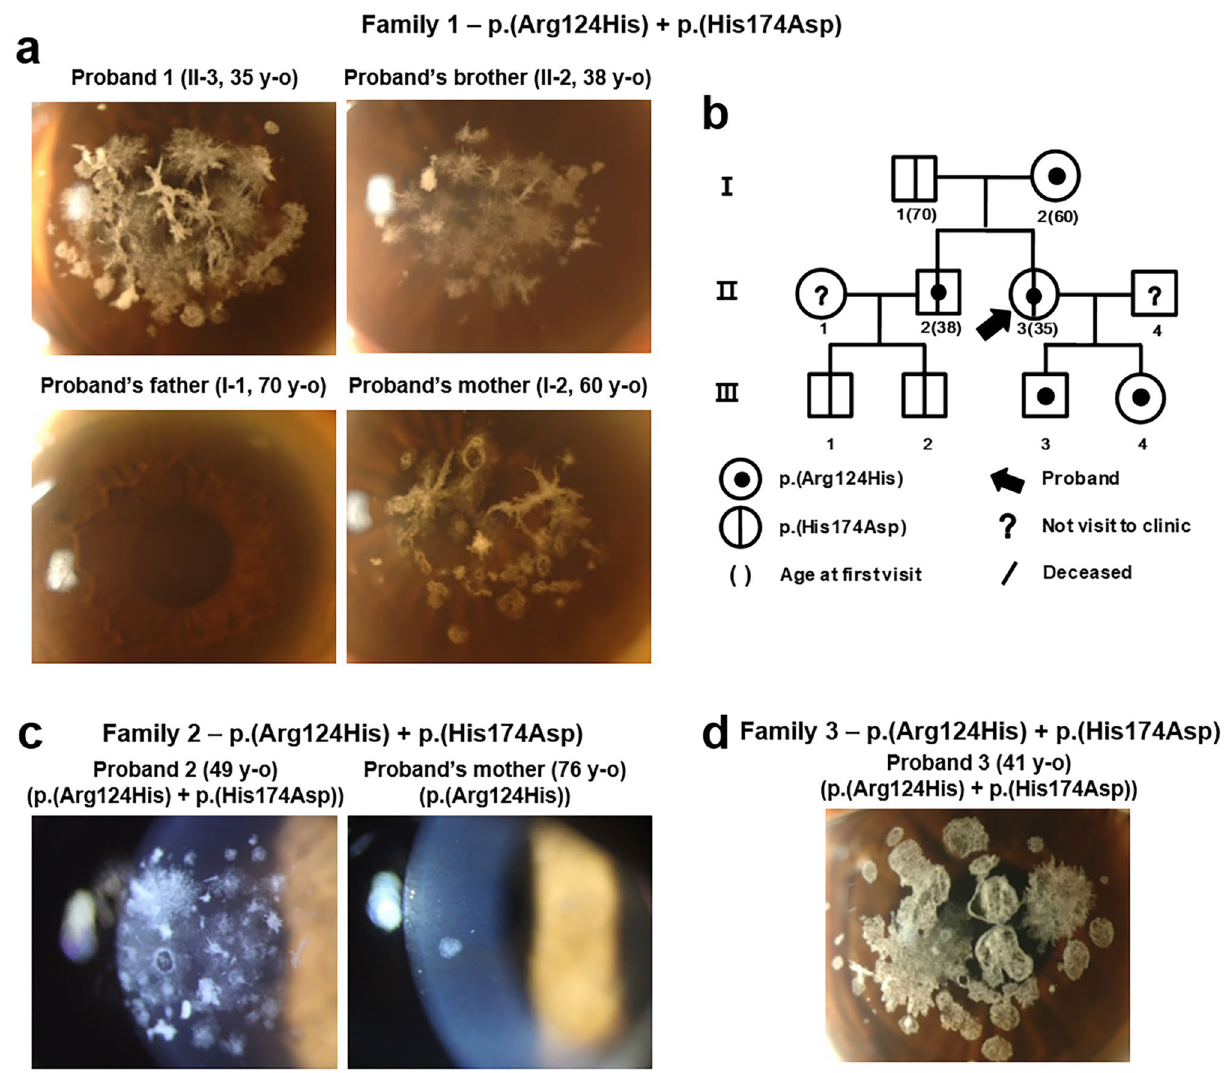
Figure 1. TGFBI p.(His174Asp) variant aggravates granular corneal dystrophy 2 caused by p.(Arg124His) mutation in a compound heterozygote. ( a ) Slit-lamp photographs of the members of Family 1. Severe confluent granular deposits with lattice deposits were observed in Proband 1. Her brother’s eyes also showed severe snowflake-like corneal deposits. ( b ) Pedigree of Family 1 showed both proband and her brother to have inherited the mutations in trans-phase. ( c ) Slit-lamp photographs of Family 2. The cornea of Proband 2 showed intensive opacities, whereas that of his mother showed mild phenotype. ( d ) Slit-lamp photograph of Proband 3 showed coarse granular and lattice